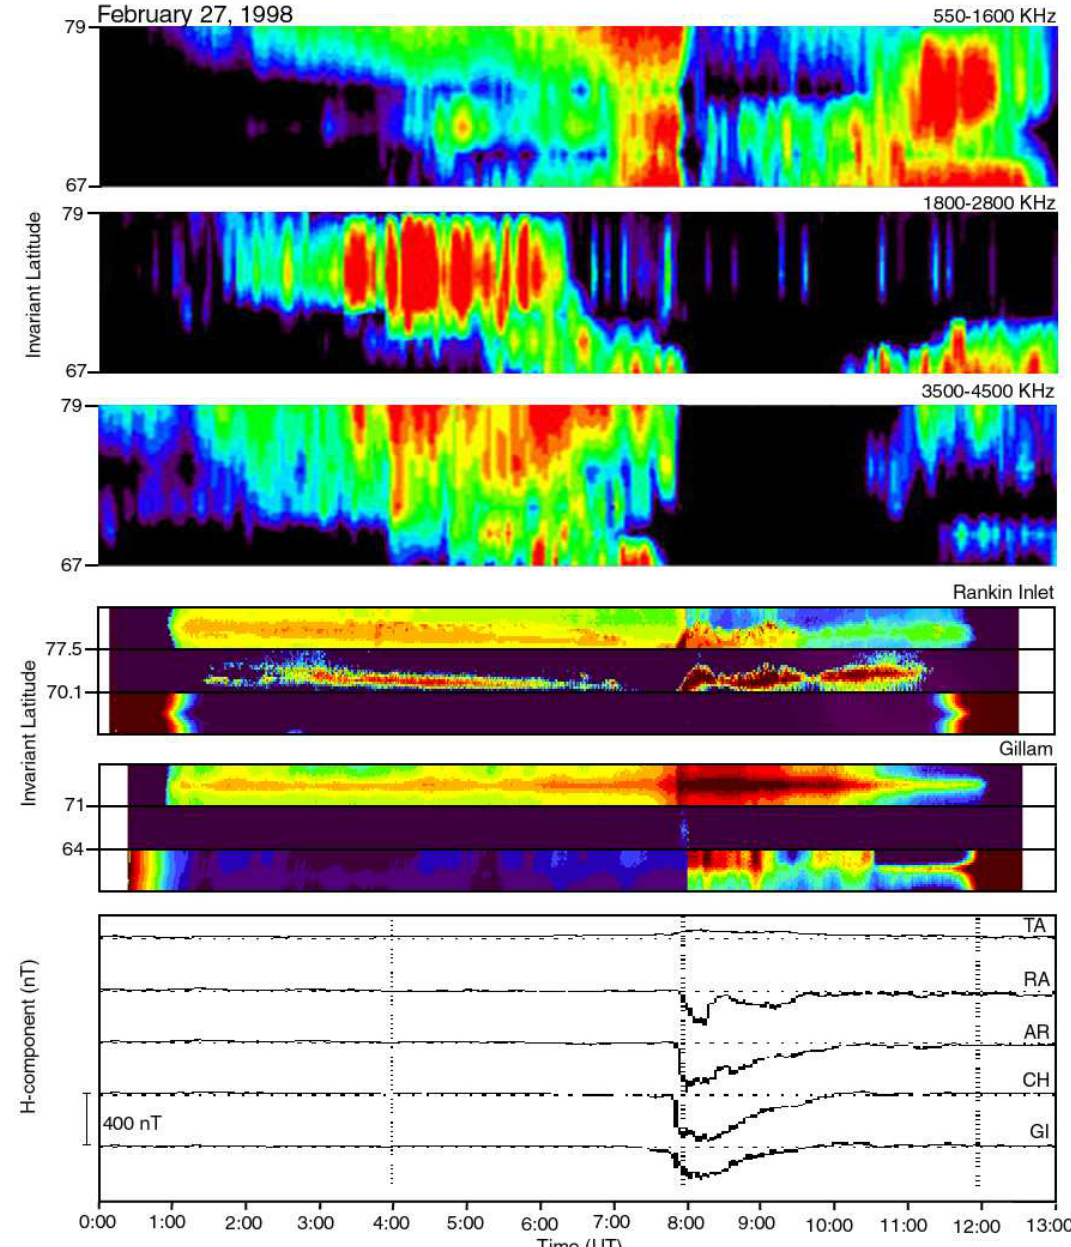
Fig. 10. (a) Radio-wave power received at five observatories in Northern Canada, integrated over the frequency range 3.5–4.5MHz and normalized to quiet day values, plotted as a function of invariant latitude for 00:00–13:00UT on 27 February 1998. (b) The same for the frequency range 1.8–2.8MHz. (c) The same for the frequency range 0550–1600kHz. (d) Meridian scanning photometer (MSP) recorded at Rankin Inlet (near Baker Lake) in three wavelengths: 5577AA (top panel), 4861AA (middle panel), and 4800AA (bottom panel),